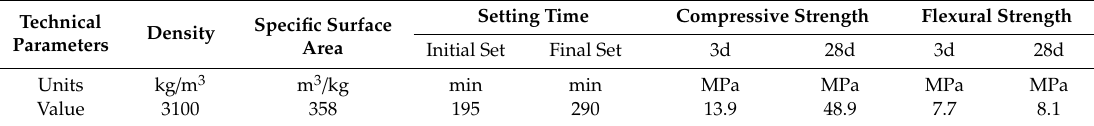
Table A1. Technical parameters of ‘P.O42.5R’ Ordinary Portland cement.